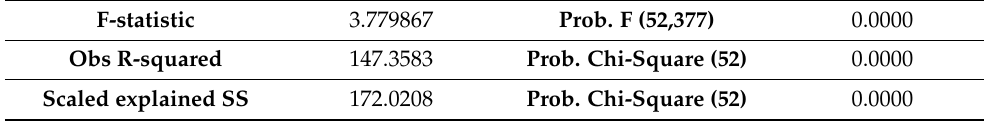
Table 5. Heteroscedasticity and White’s test.